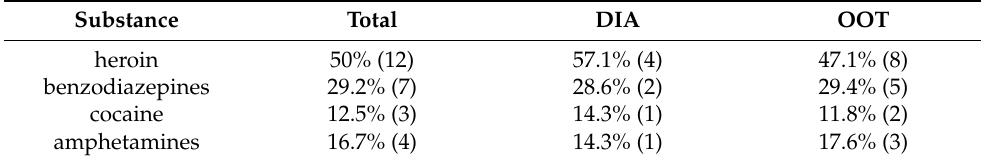
Table 2. Screening results of urine samples from OUD patients with comorbid ADHD. Absolute numbers of participants are in